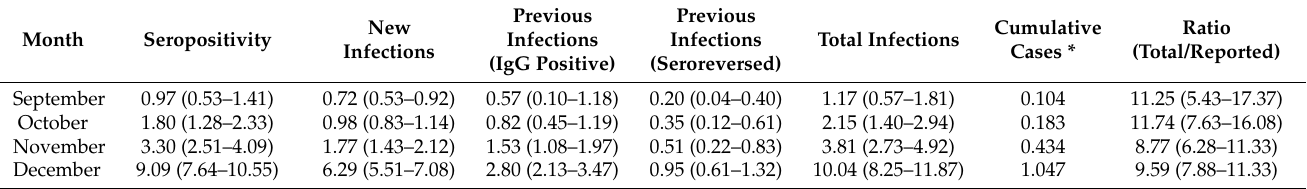
Table 1. Estimated proportion (%, 95% CI) of (actual) new, previous, and total cumulative infections for each month based on seroprevalence (S3)